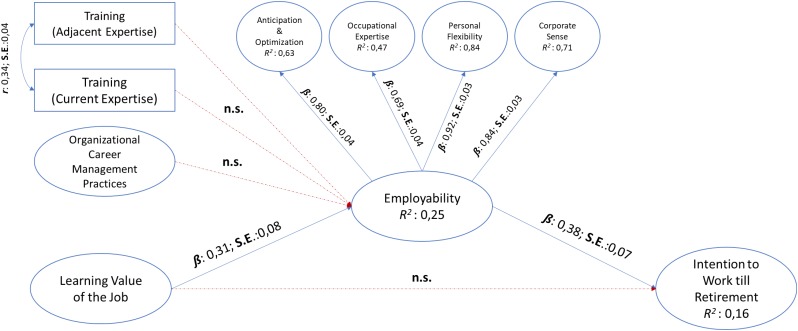
Structural model for Study 1 without control variables.